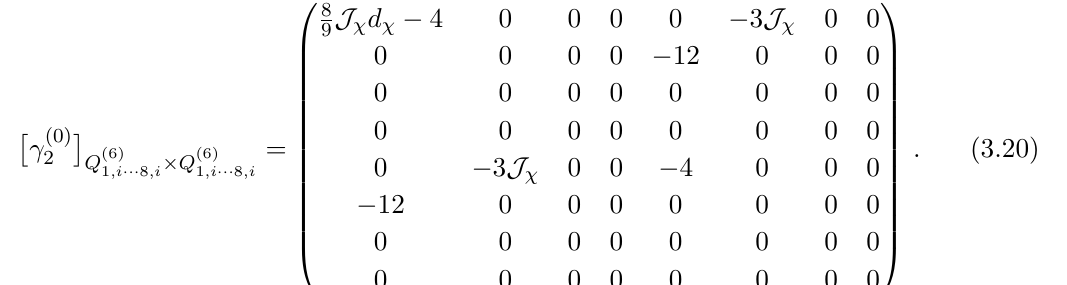
Figure 8 . The renormalization of the operators Q (6) B (cid:22) ; W a penguin insertion (right-handed quarks and leptons can also be on the external (cid:22)